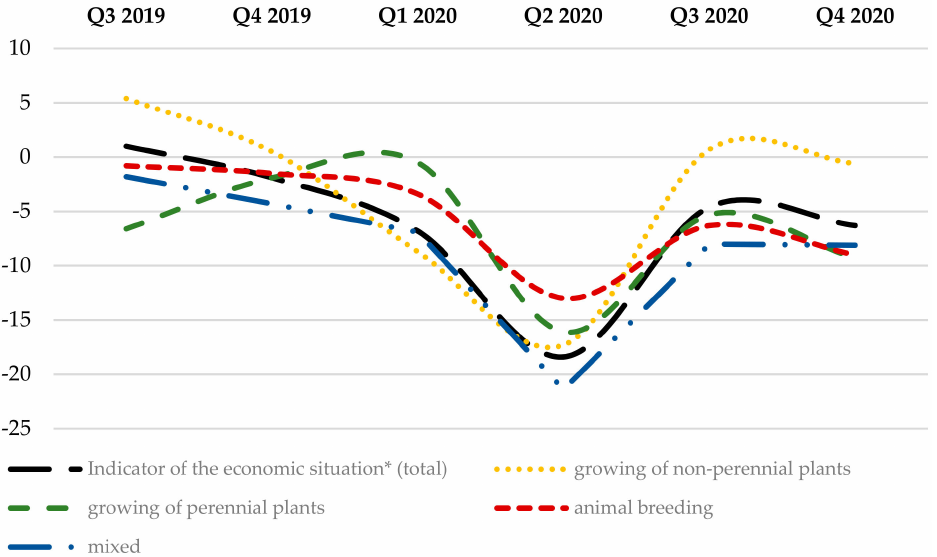
Figure 1. Economic effects of the COVID-19 pandemic on Polish food producers in 2020. * The indicator reflects the economic situation in agriculture and in selected types of farming. Source: own compilation based on data